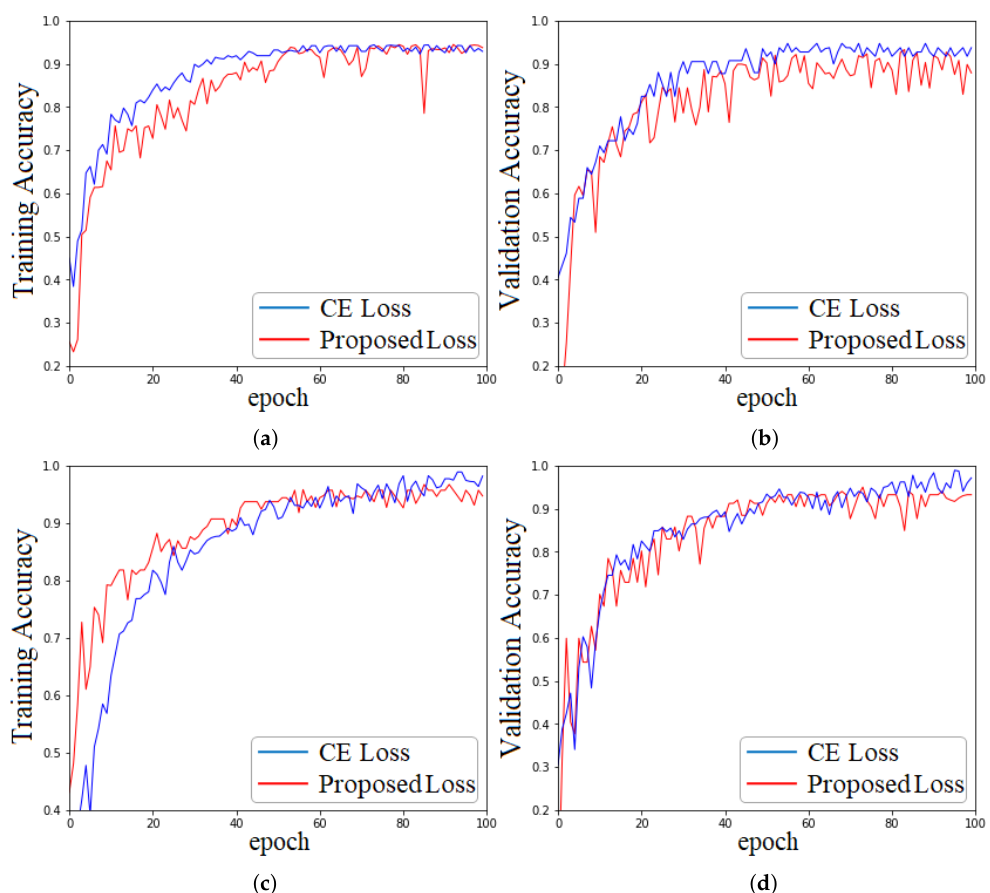
Figure 8. Comparison between results of the BC and the proposed loss. ( a ) training curves of classifier model; ( b ) validation curves of classifier model; ( c ) training curves of controller model; ( d ) validation curves of the controller